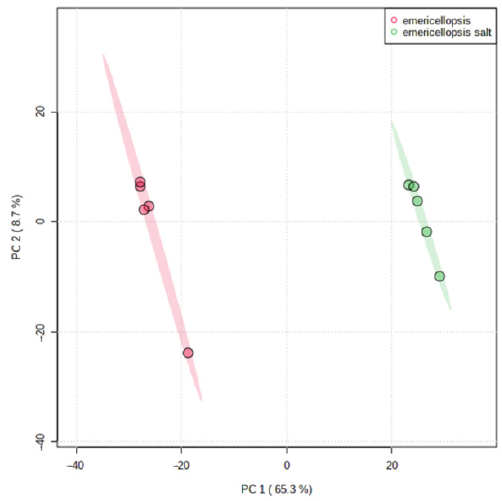
Figure 4. Principal Component Analysis (PCA) scores plot of salted and non-salted extracts of Emericellopsis cladophorae MUM 19.33. Green represents salted extracts and in red non-salted extracts.